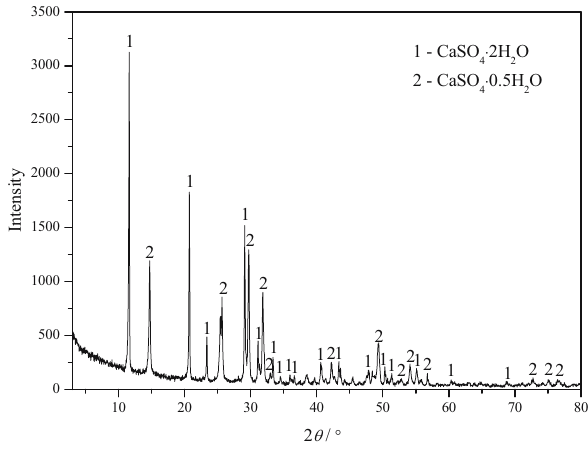
Figure 1: XRD pattern of neutralization fi lter residue sample ( HWWS - PG )